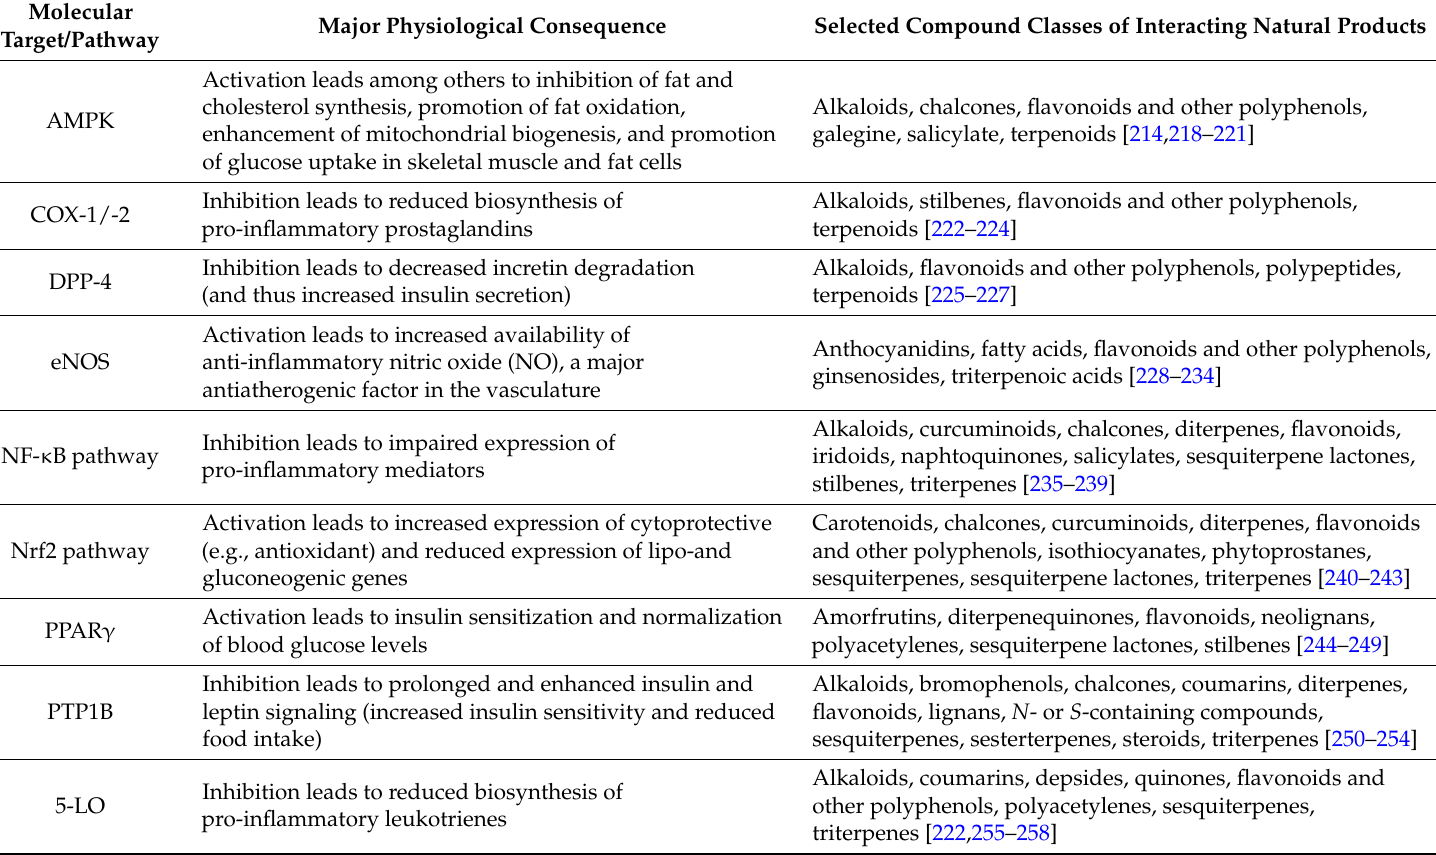
Table 3. Selected molecular targets relevant for cardiovascular and metabolic disorders, which are well known to be affected by diverse natural